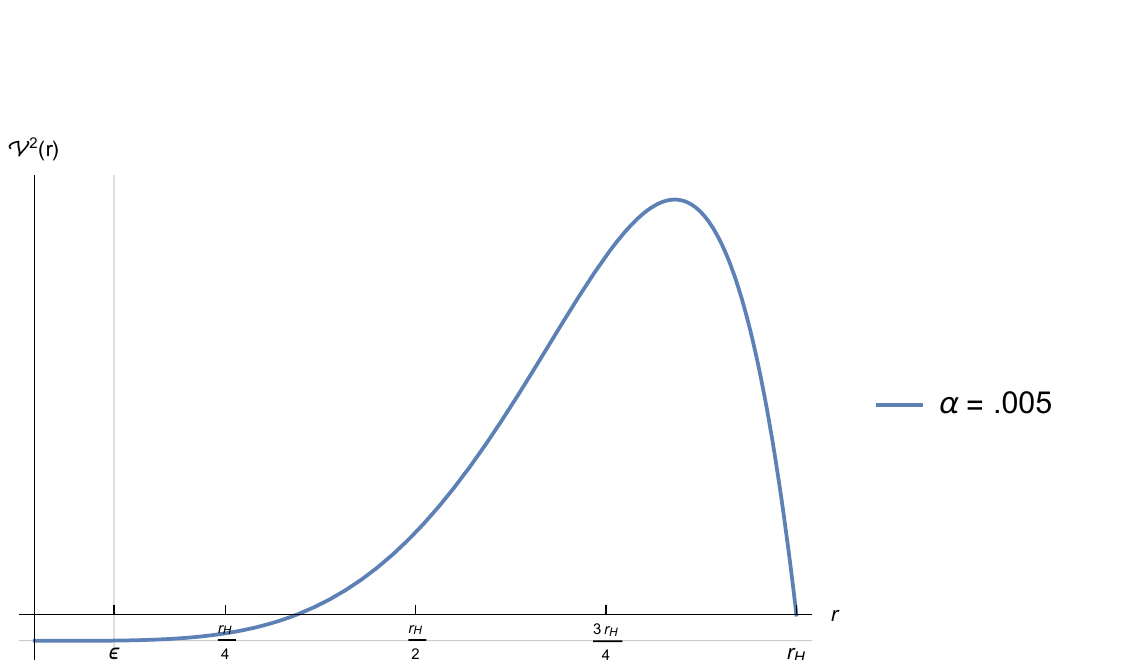
2 ( r ) of the volume functional for the α -corrected AdS-Schwarzschild Figure 15. The square V geometry in the GB theory, with the cutoff in eq. (5.2) marked.